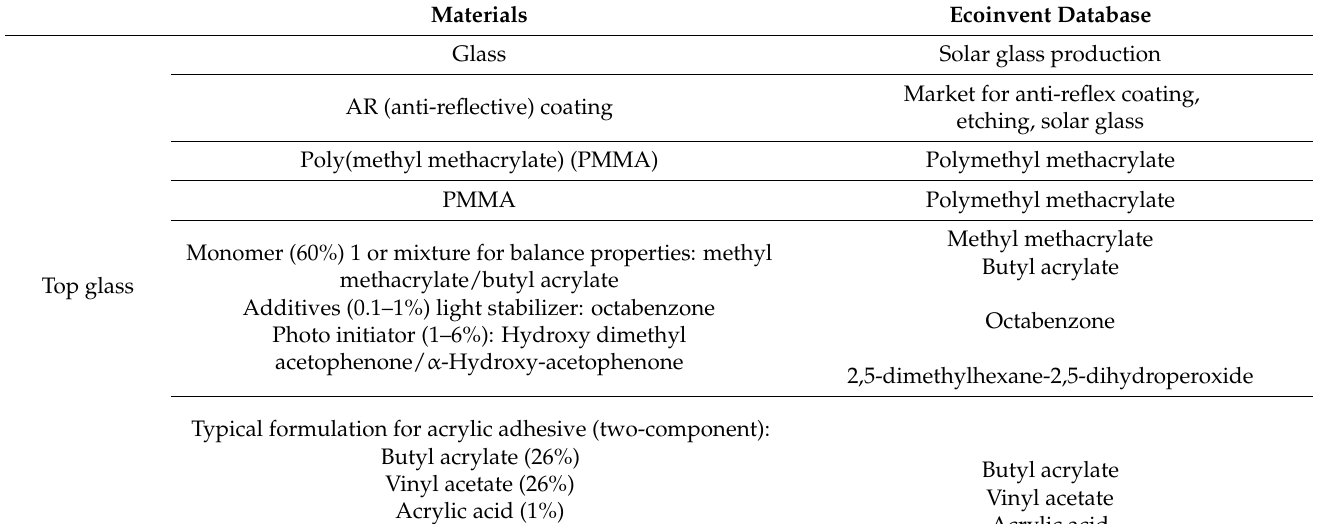
Table 2. Inventory table for HCPV